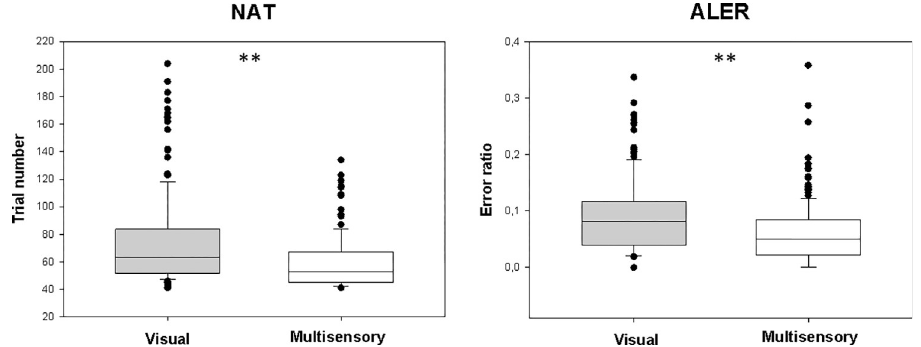
Fig 2. Performance in the acquisition phase in the visual and audiovisual paradigms. NAT: the number of trials needed to complete the acquisition phase; ALER: error ratio in the acquisition phase. Gray: visual; white: audiovisual. The lower margin marks the first quartile and the upper margin the third quartile. The line in the box marks the median. The whiskers below the boxes indicate the 10th percentile and the whiskers above, the 90th percentile. The black dots represent the outliers. �� : p < 0.01.